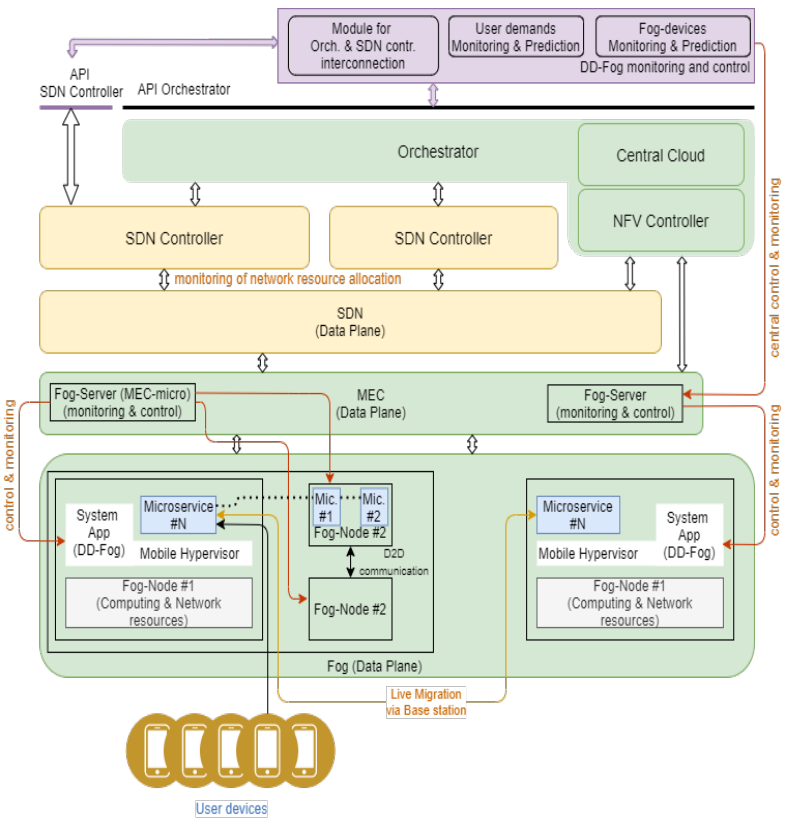
Figure 1. The common architecture of the